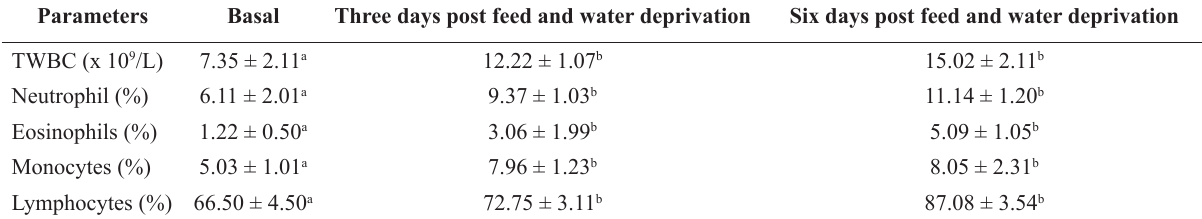
Values within the same rows with different superscripts are significantly different at p<0.05. TWBC: Total white blood cell. (p<0.05) over time compared to the basal parameters. Table 3 : biochemical parameters of male rats deprived of feed and water for six consecutive days Parameters Basal Three day days post feed and water Glucose (mg/dL)